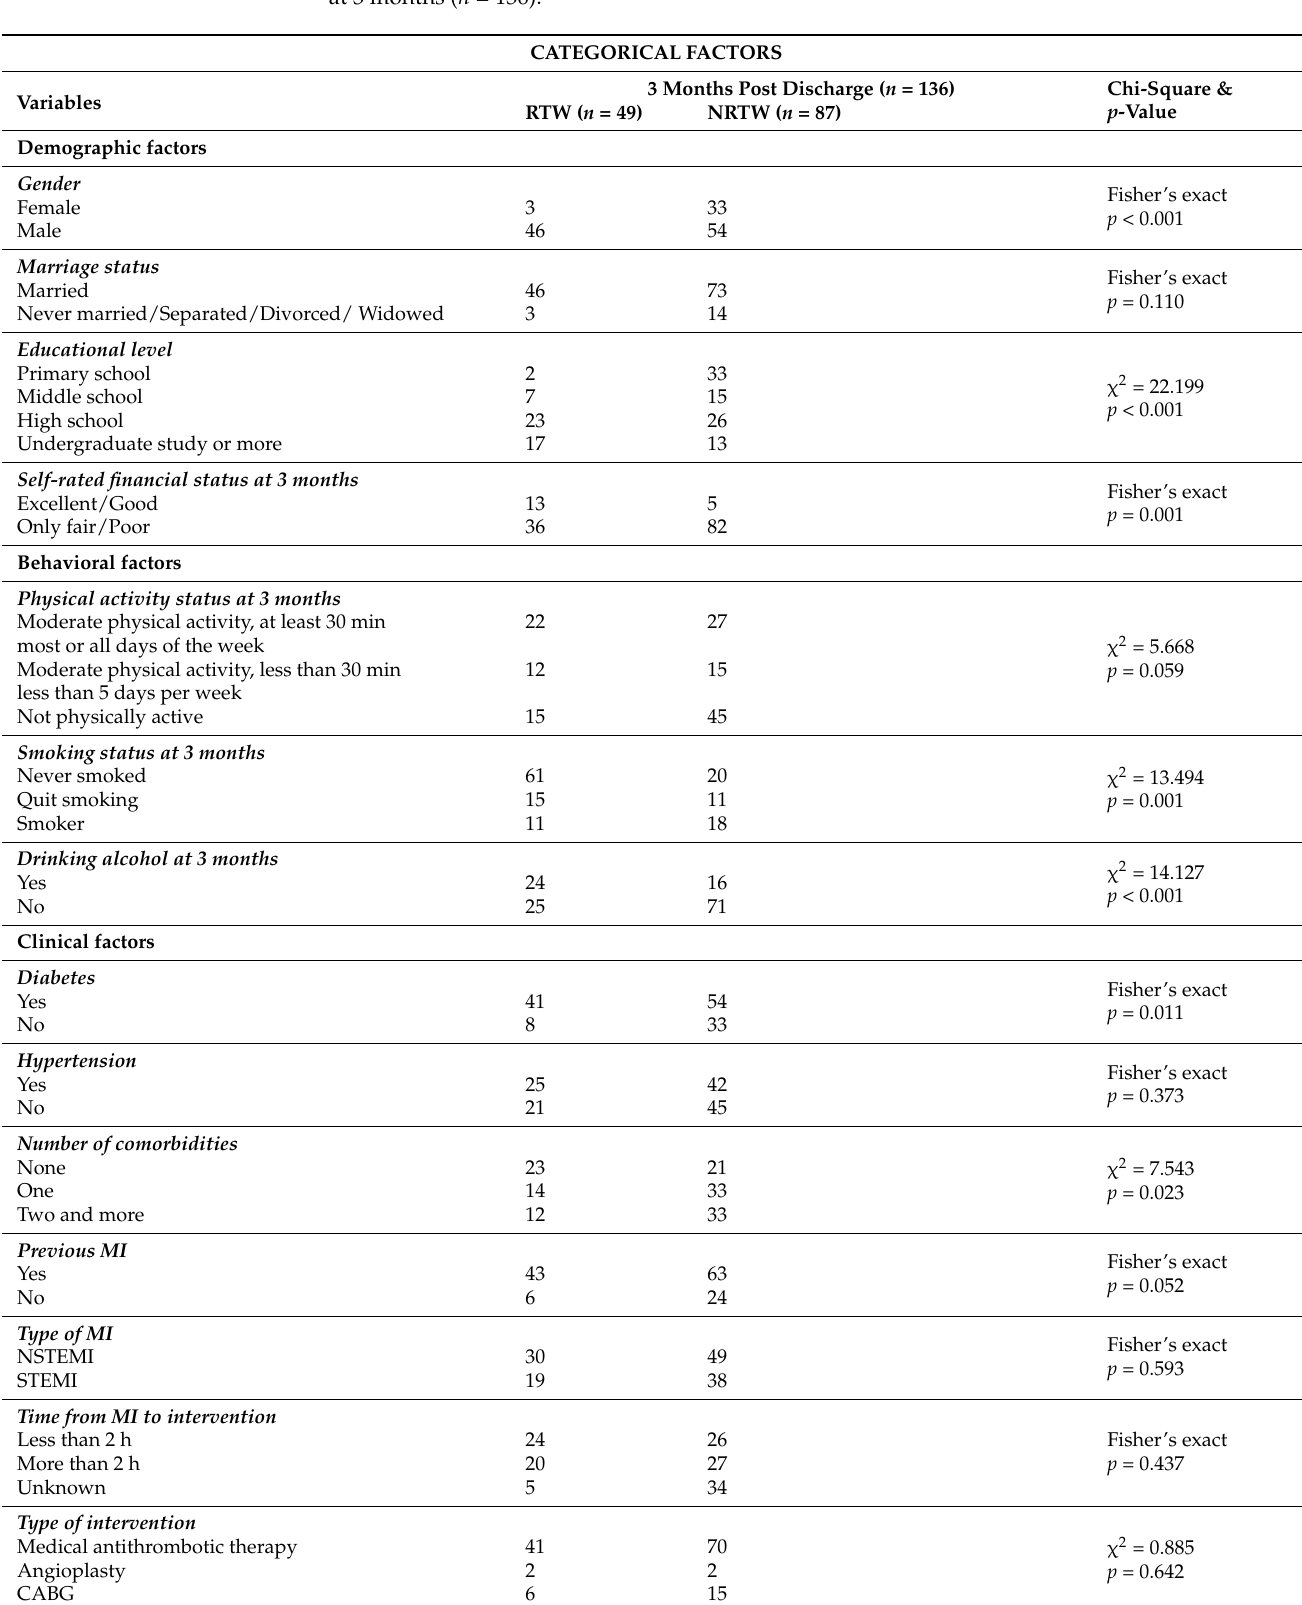
Table 2. Differences in characteristics of MI patients between those who were and were not working at 3 months ( n =